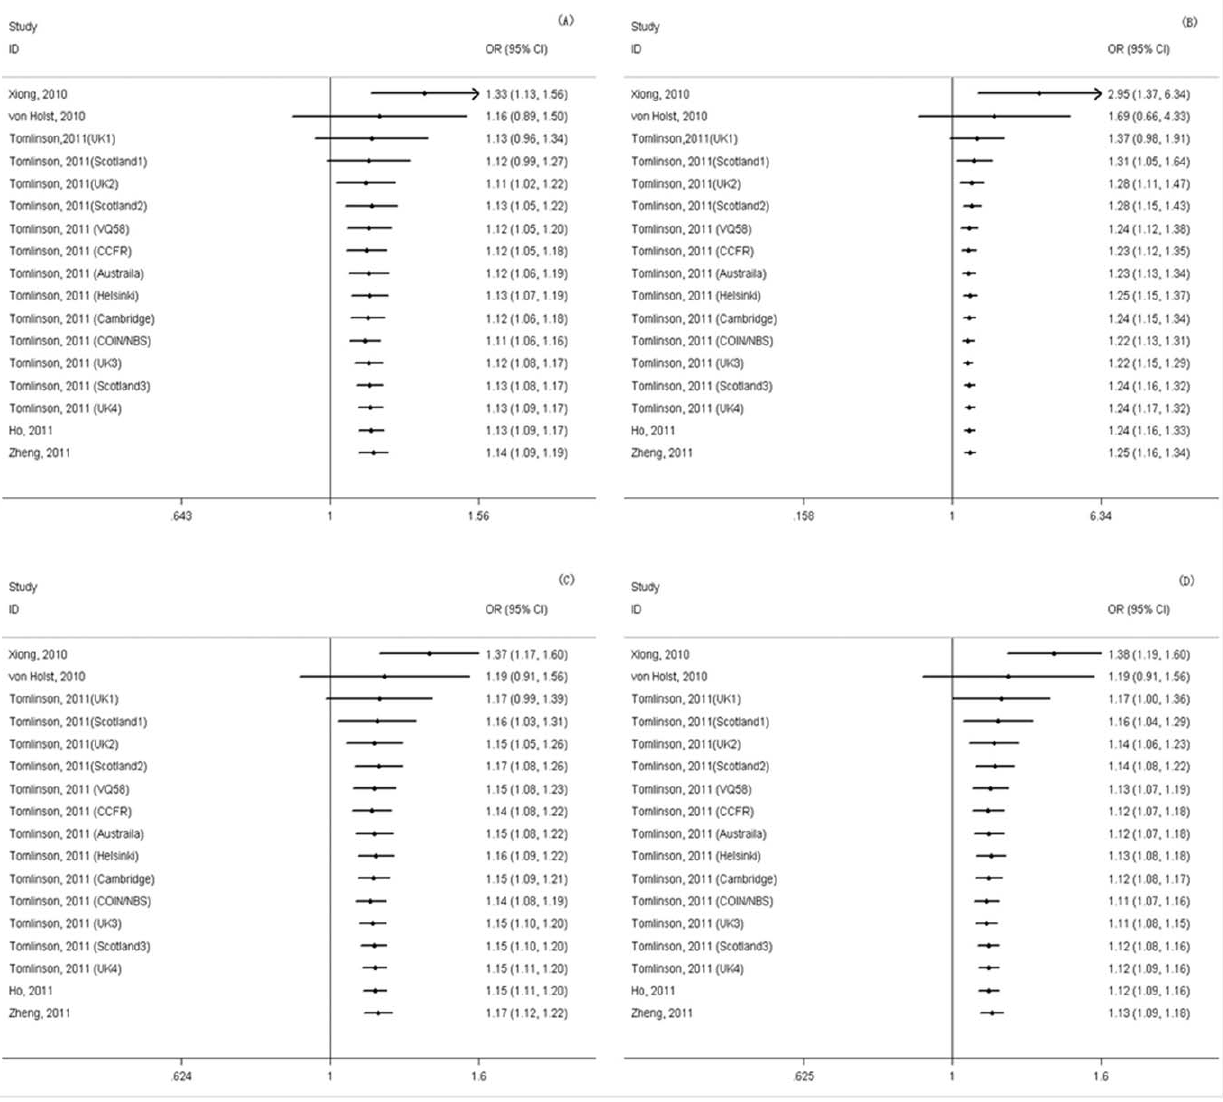
Figure 1. Forest plots of cumulative meta-analysis of rs961253 in association with colorectal cancer by published year under different genetic models. (A) the CA versus CC; (B) the AA versus CC; (C) the dominant model; (D) the additive model.